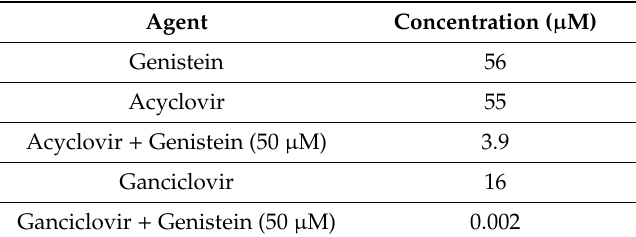
Table 1. Calculated IC 50 Values against B